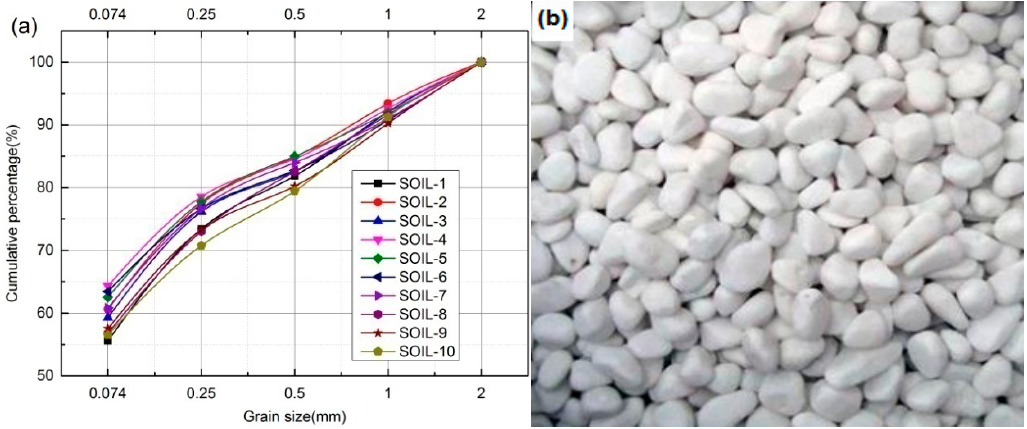
Figure 4. The soil and rock blocks used in the preparation of bimsoil samples [5]: ( a ) grain size distribution of soil matrix, with particle size larger than 0.074; and ( b ) rock blocks used in bimsoil samples, size range between 2 and 5 mm. Table 1. Basic physical and mechanical properties of the used soil matrix and rock blocks for bimsoil samples.